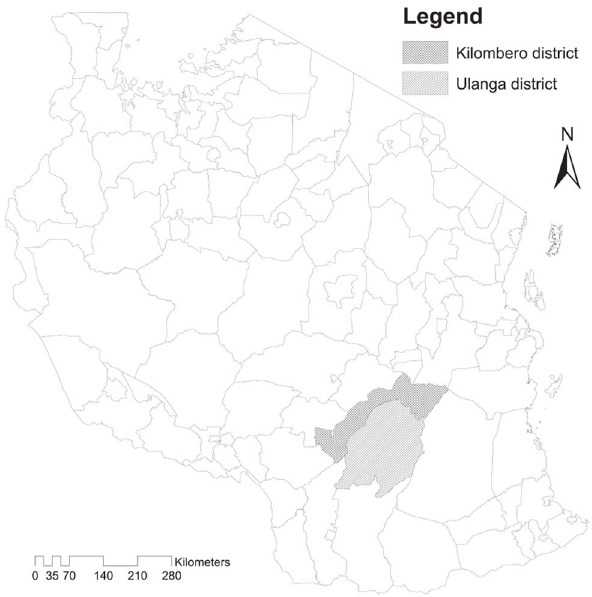
Figure 2. Phases of fieldwork.